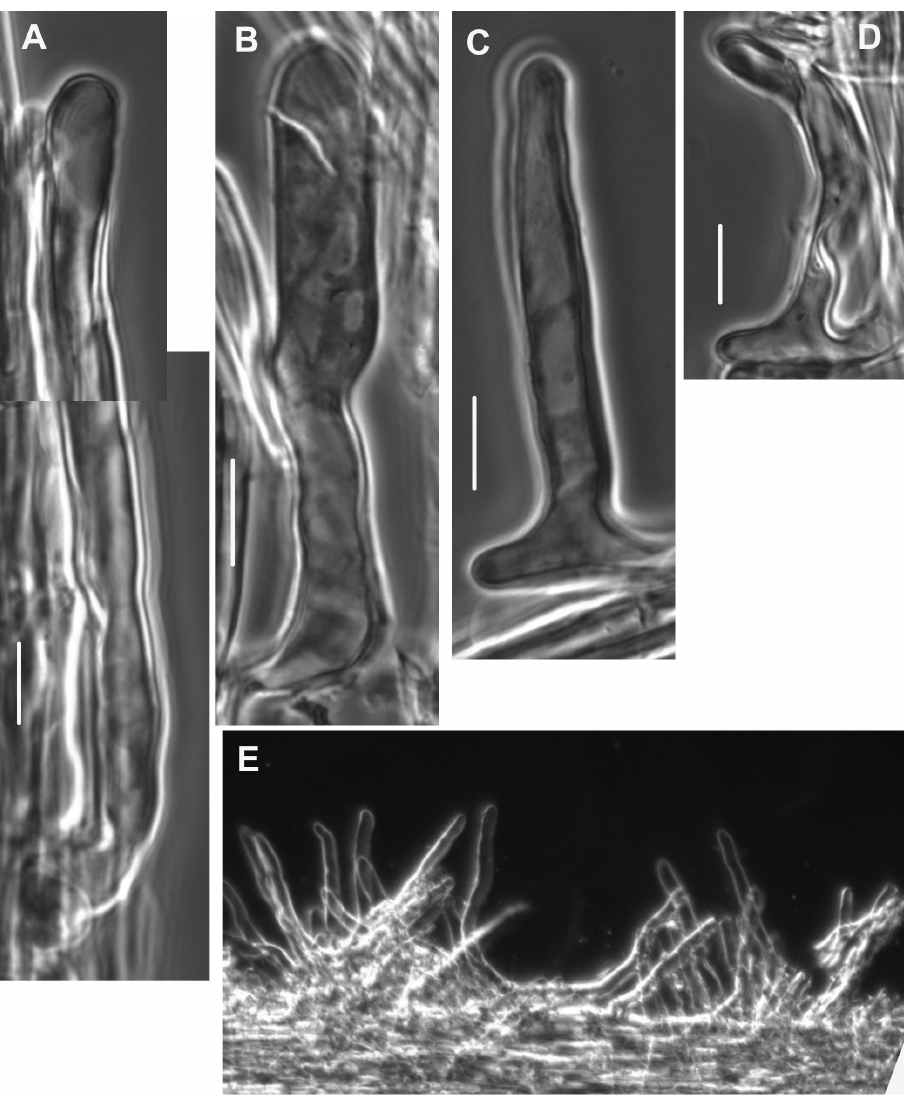
Figure 10. Mycetinis alliaceus . Caulocystidia from upper stipe. A Repent caulocystidium against stipe surface B–D Caulocystidia perpendicular to stipe surface E General view of lower stipe surface. Standard bars = 10 µm. TFB 11451